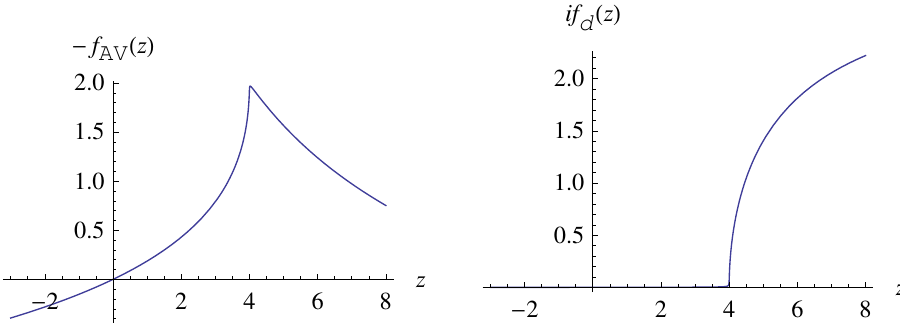
Figure 18 . Average and di(cid:11)erence continuations of the massive